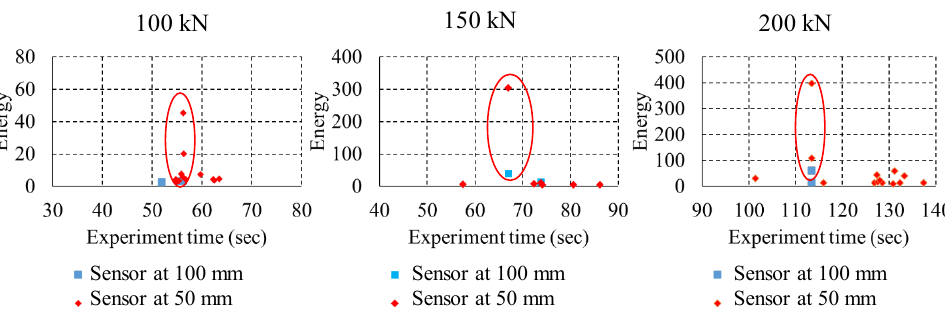
Figure 11. Sample signal from each cluster from AE dataset generated under 150 kN load.